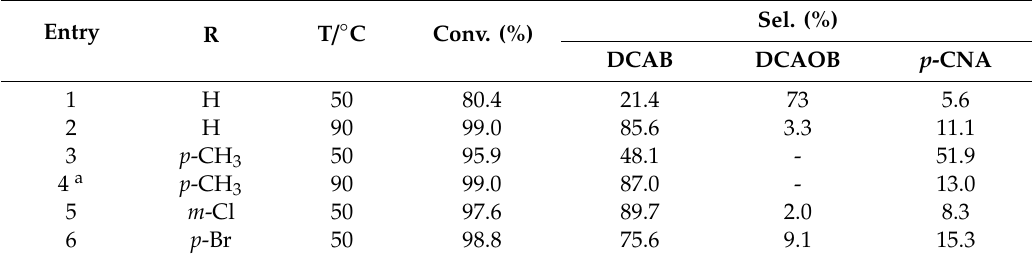
Table 3. Hydrogenation of di ff erent substituted nitrobenzenes over Pt catalyst.